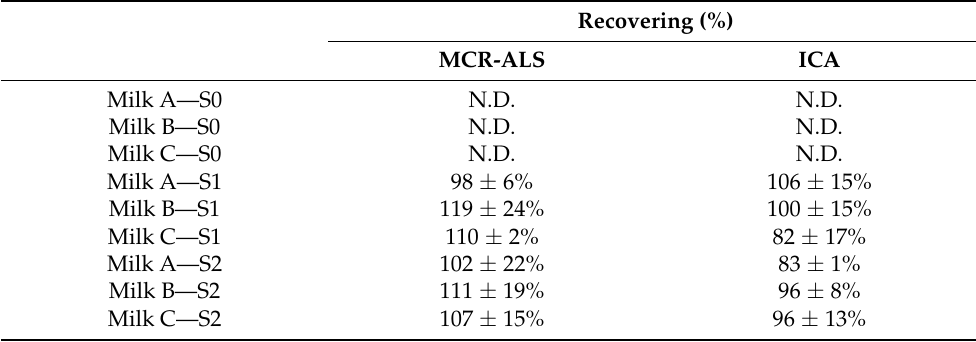
Figure 11. ( a ) Recovered SERS spectrum and ( b ) score map for TMP, ( c ) recovered SERS spectrum and ( d ) score map for interferent 1, and ( e ) recovered SERS spectrum and ( f ) score map for interferent 2 in milk analysis. Table 2. TMP recovered from commercial milk samples at different spiking levels: S0 (not spiked),